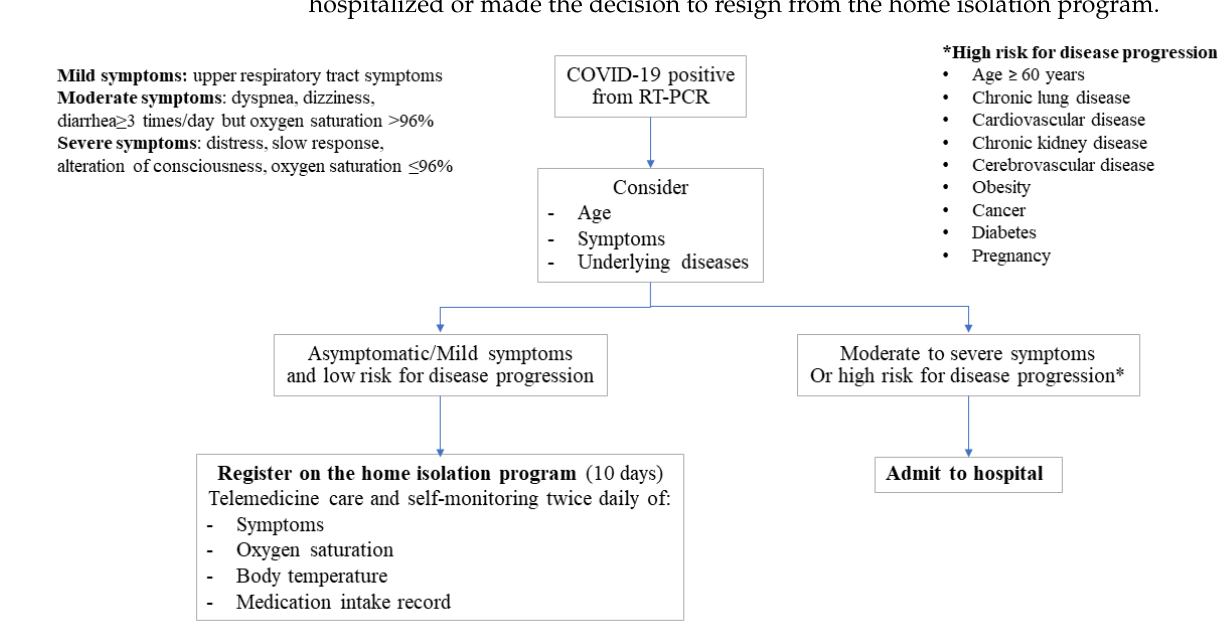
Figure 1. Management plan.